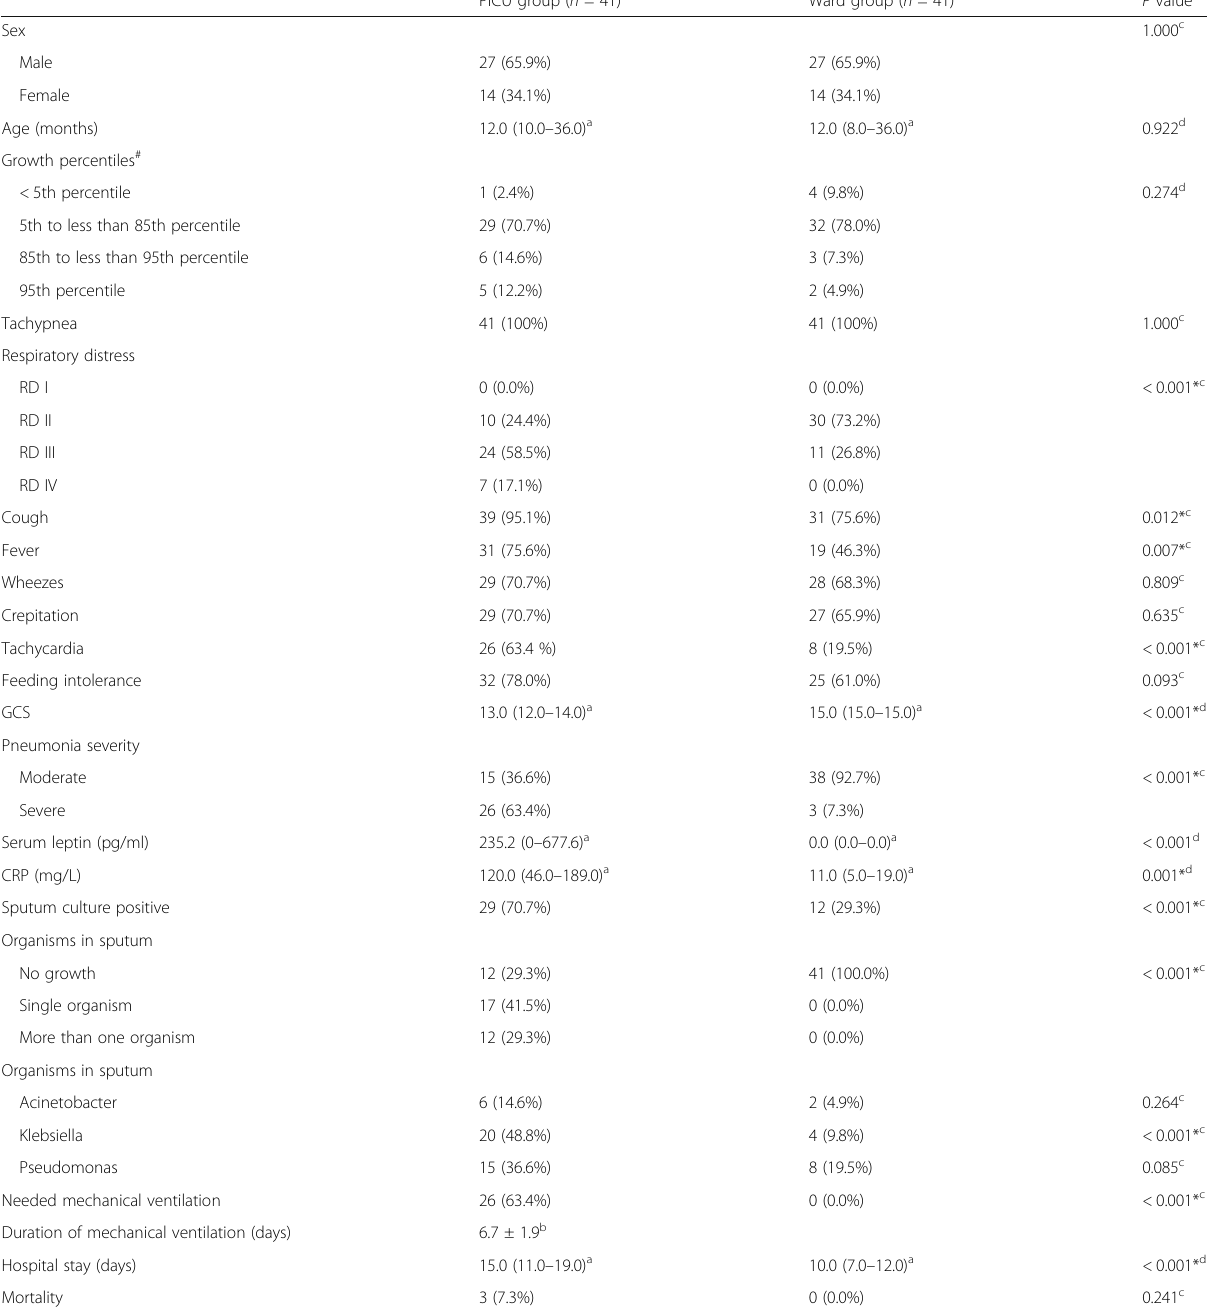
Table 1 Characteristics of the PICU and ward